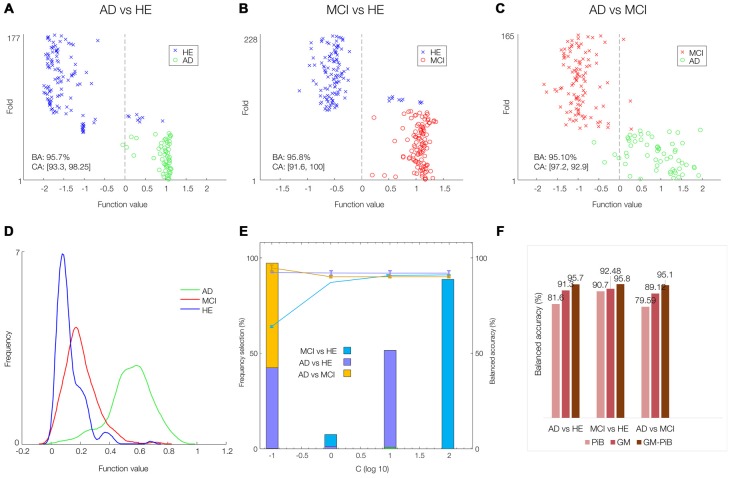
AD classification by simple multi-kernel learning (sKML) using combined GM-PiB imaging data. (A–C) Prediction plots (per fold). The decision threshold is displayed by a vertical line at the center of the plot. (D) Corresponding histograms of the function values of three groups modeled by sMKL. (E) Performance curve depending on the hyper-parameter values (C = 0.1, 1, 10, 100) with frequency of selection of each hyper-parameter, for three binary classification problems. (F) A summary of classification accuracies obtained by single and multi-modal data.